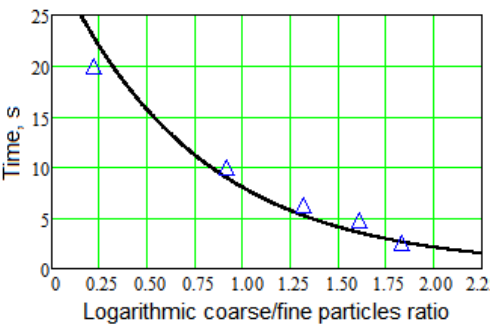
Figure 6. Experimental results and the corresponding approximation curve.